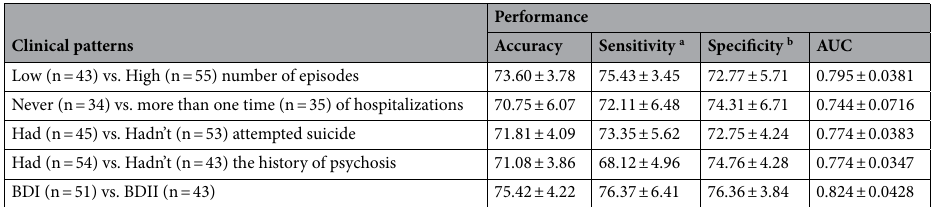
Table 2. Model performance for classifying fewer and more occurrences groups divided from clinical patterns. AUC area under the ROC curve, BDI bipolar type 1 disorder, BDII bipolar type 2 disorder. a Sensitivity of more occurrences group or BDI. b Specificity of more occurrences group or